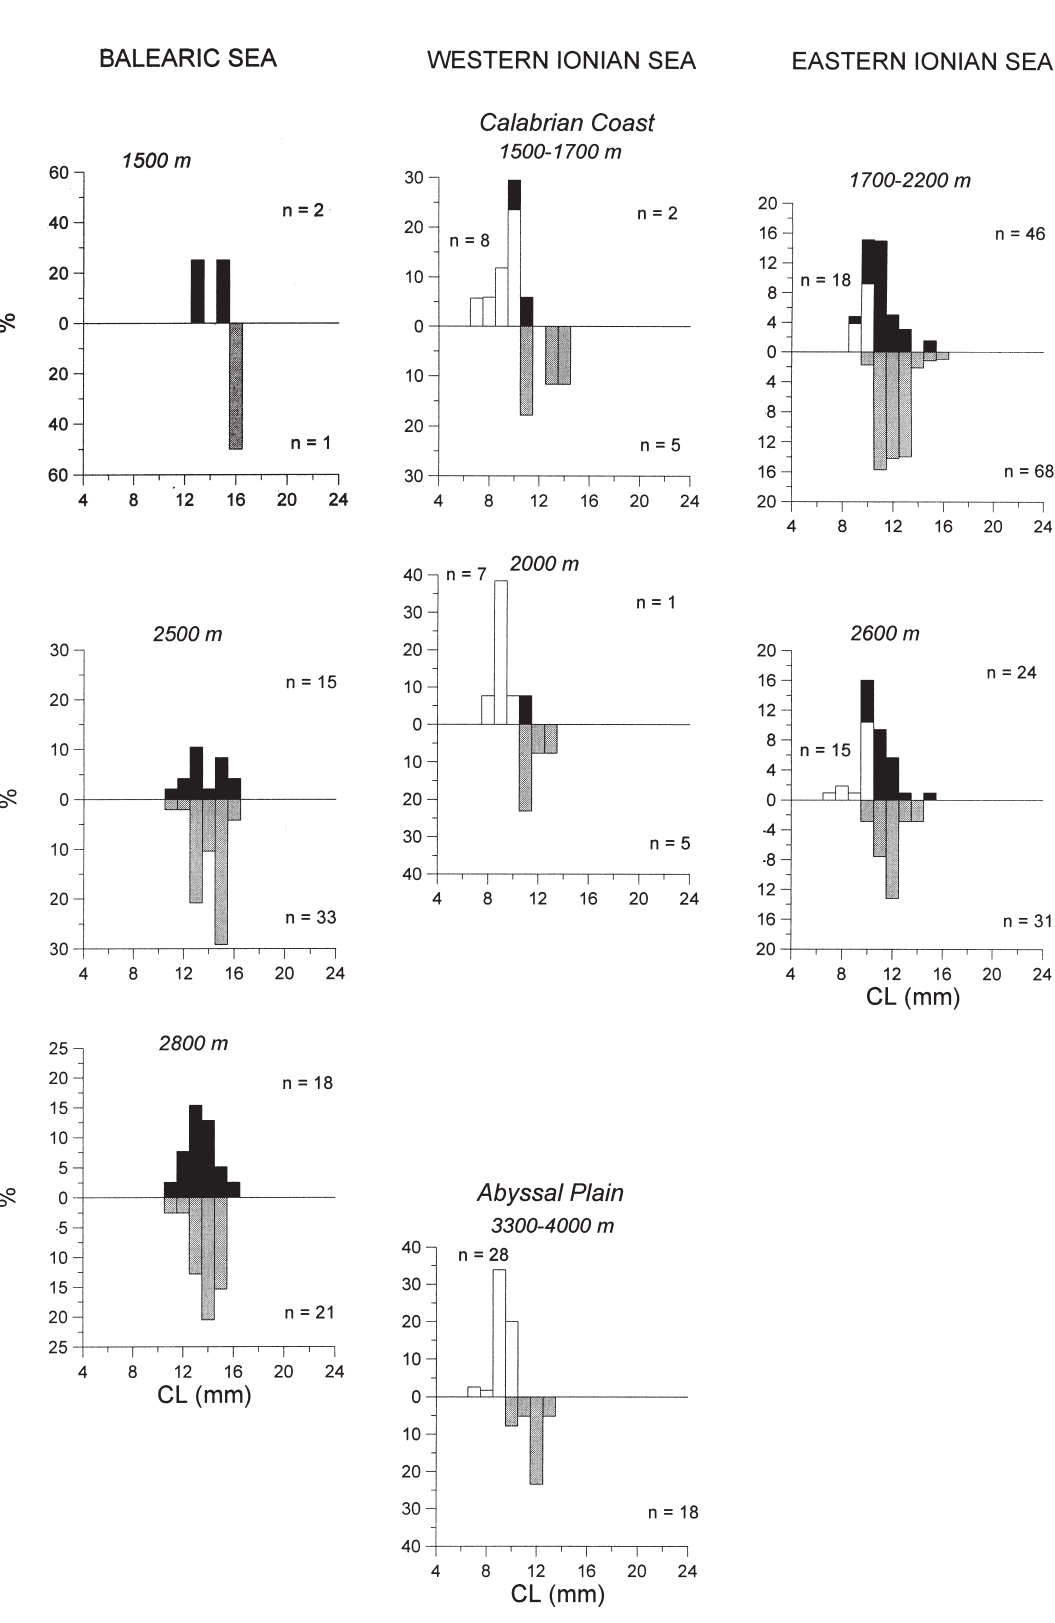
F IG . 6. – Size frequencies and sex distribution by depth interval for Nematocarcinus exilis, one of the two most abundant deep-sea decapods dwelling below 1000 m depth in the western and central Mediterranean Sea. White bars, indeterminate sex individuals; black bars, males; grey bars, females; n, number of